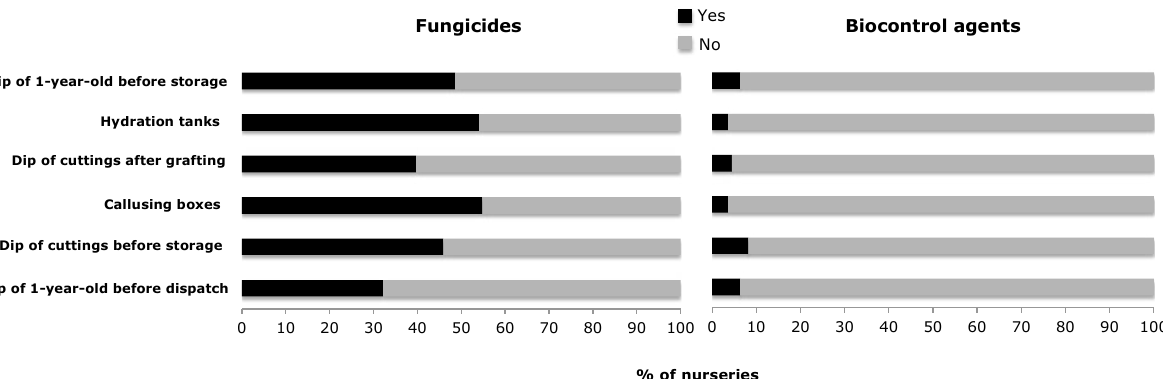
Figure 2. Treatment applications of fungicides or biocontrol agents in any of the stages of grapevine propagation